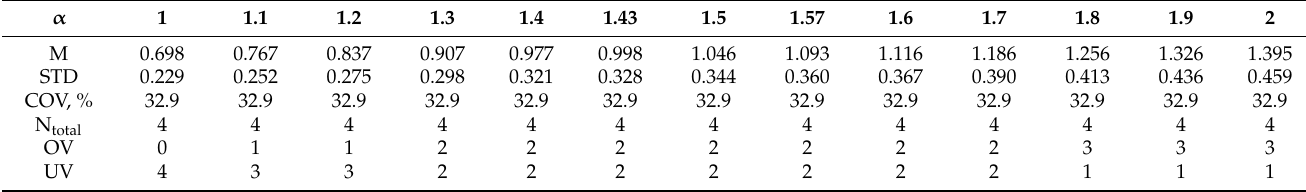
Table A10. The influence of α on the statistical results of L t.teor /L t.exp of BFRP bars.